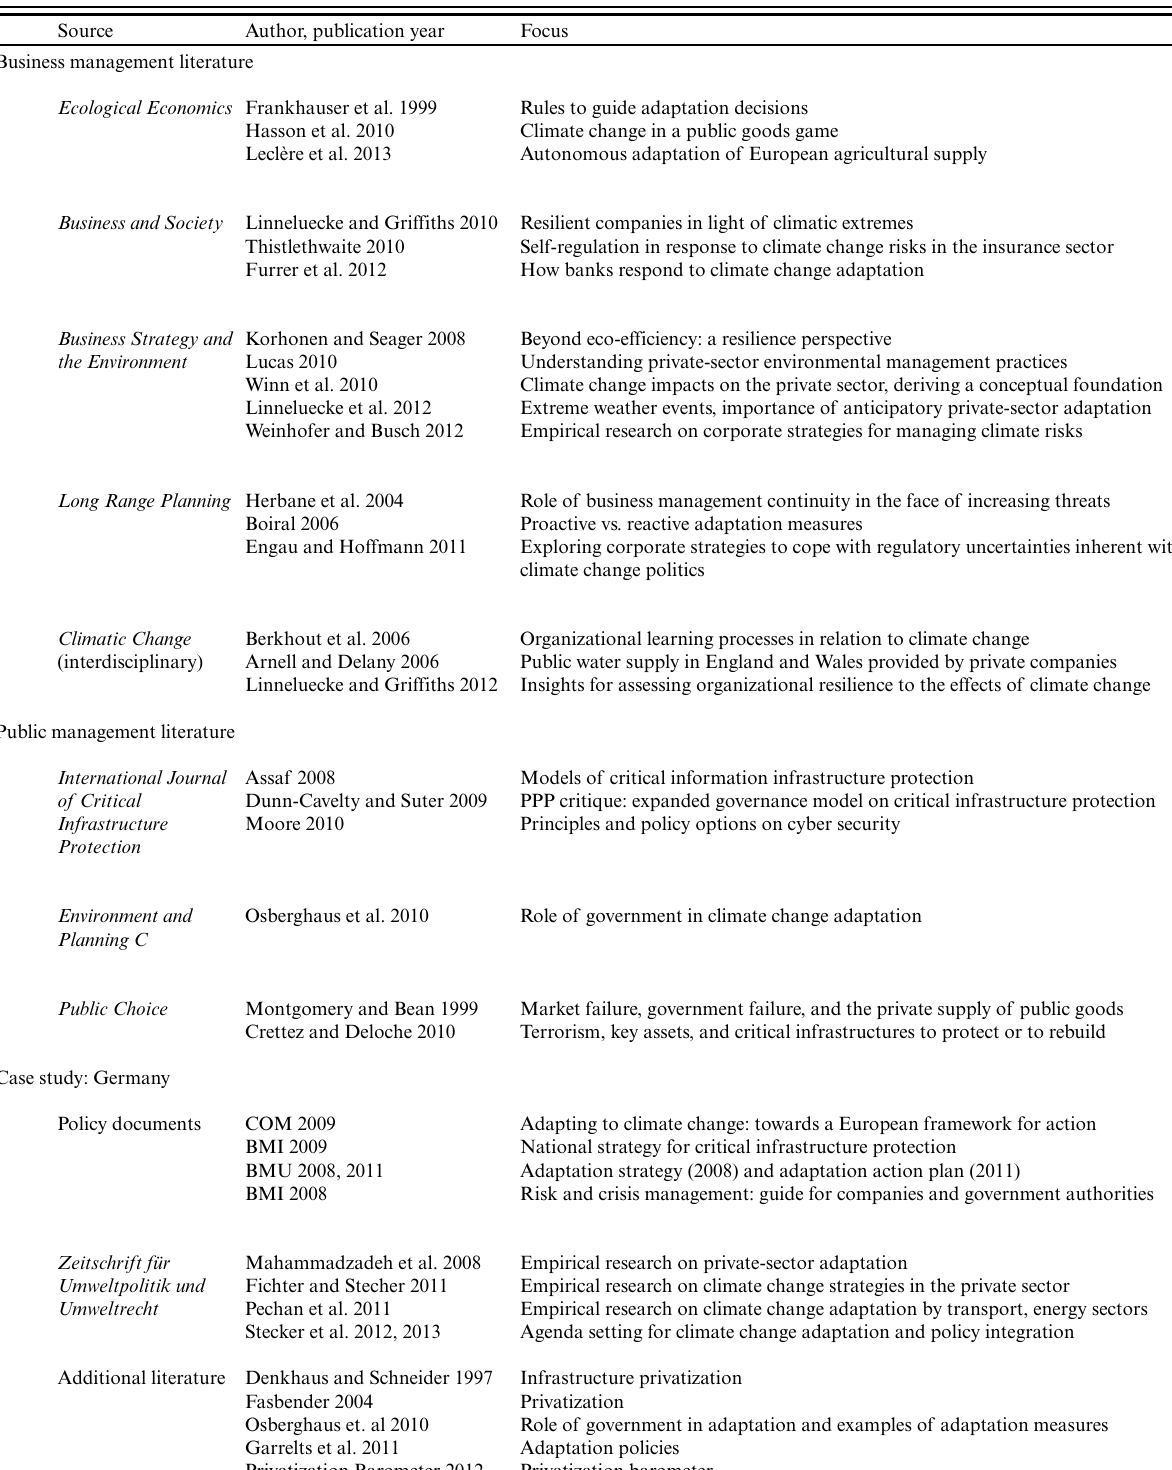
Table 1 . Results from literature